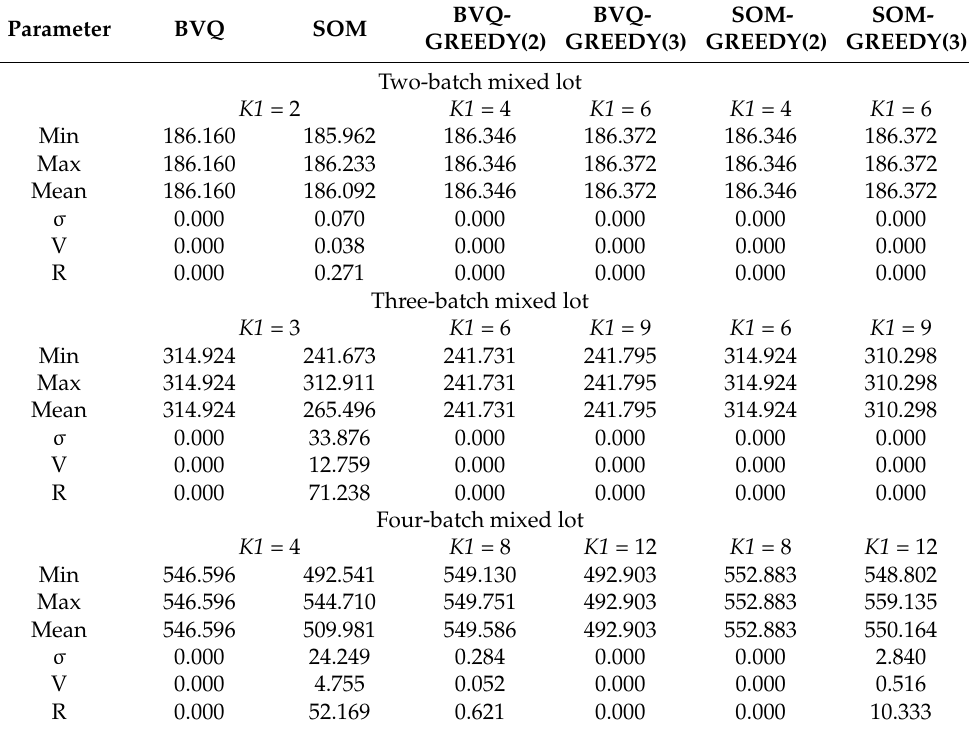
Table A7. Objective function value summarized after 30 attempts (squared Euclidean distance, initialization by average).